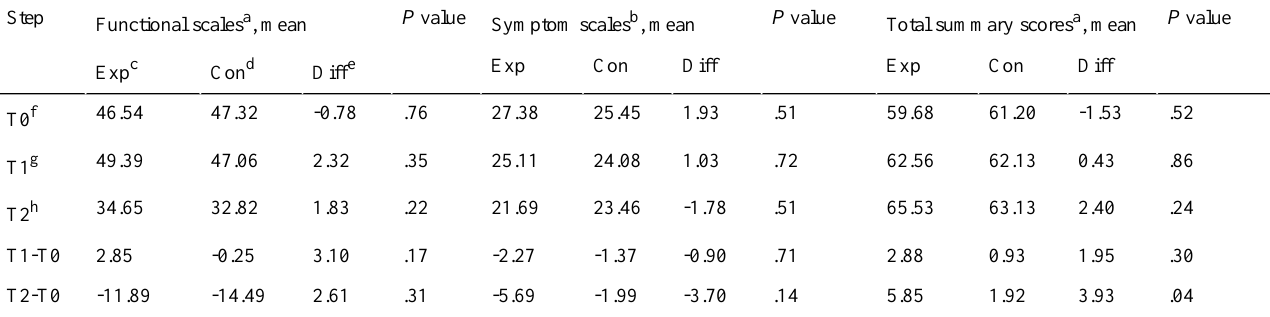
Table 4. Generalized estimating equation analysis of longitudinal outcome of the Breast Cancer-Specific Quality-of-Life Questionnaire (N=112).